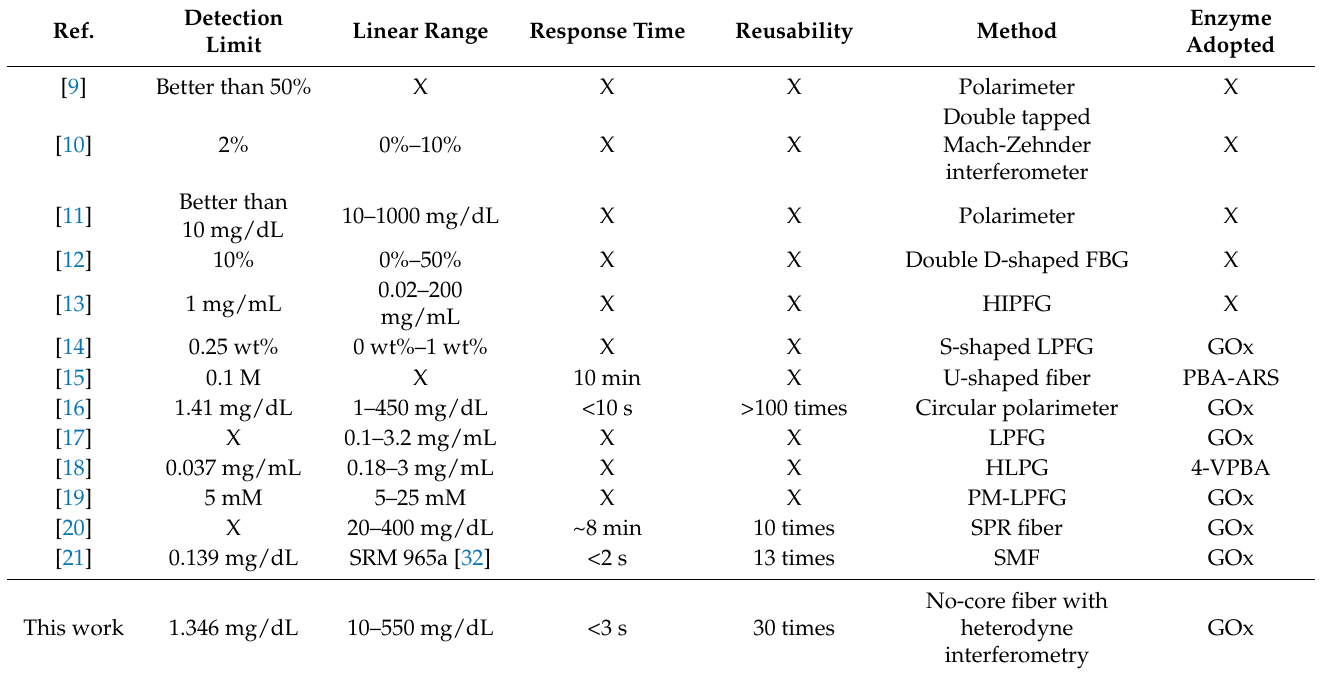
Table 2. Performance comparison of relevant